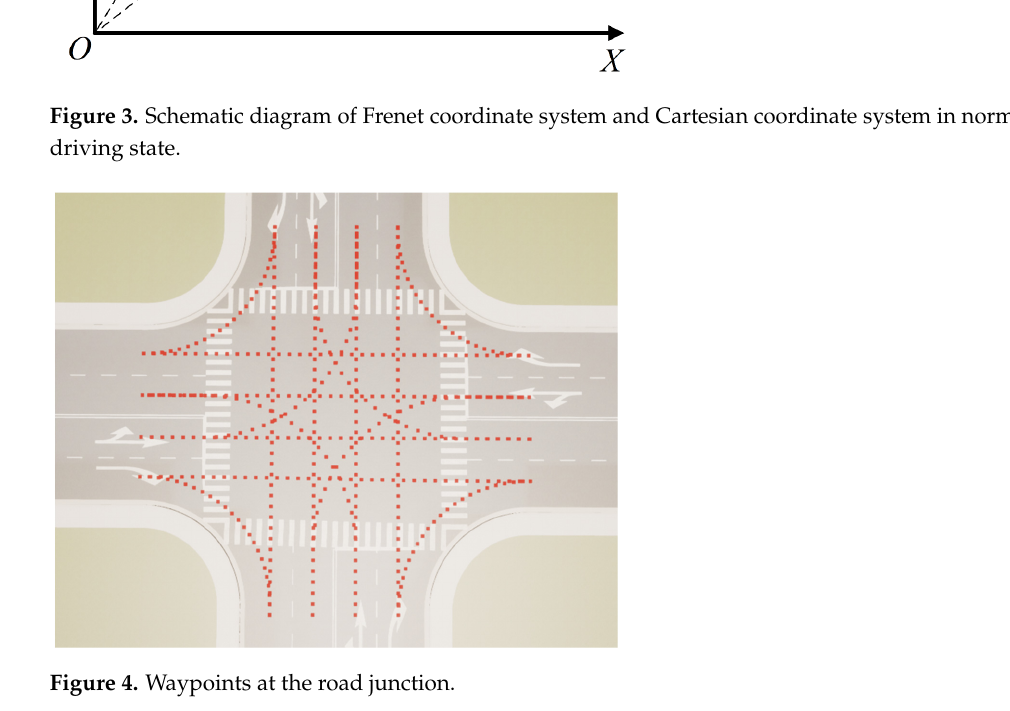
Figure 3. Schematic diagram of Frenet coordinate system and Cartesian coordinate system in normal driving state.